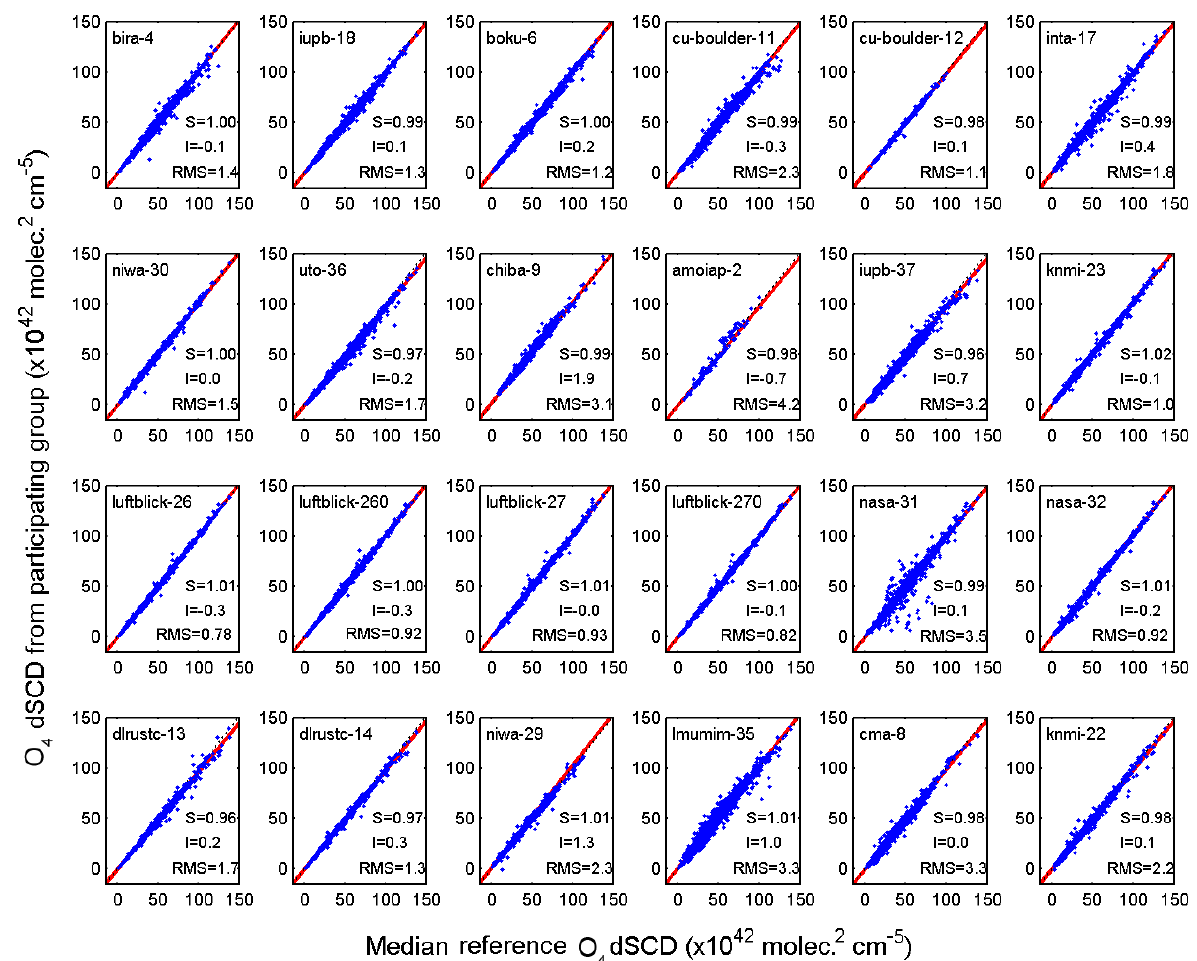
Figure 11. Same as Fig. 10 but for O 4 dSCDs measured in the visible wavelength